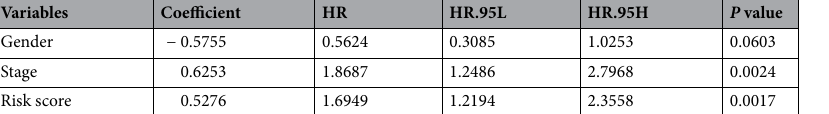
Table 3. The construction of PDEARGs-based systematic prognostic signature. HR hazard ratio, HR.95H and HR.95L 95% confidence